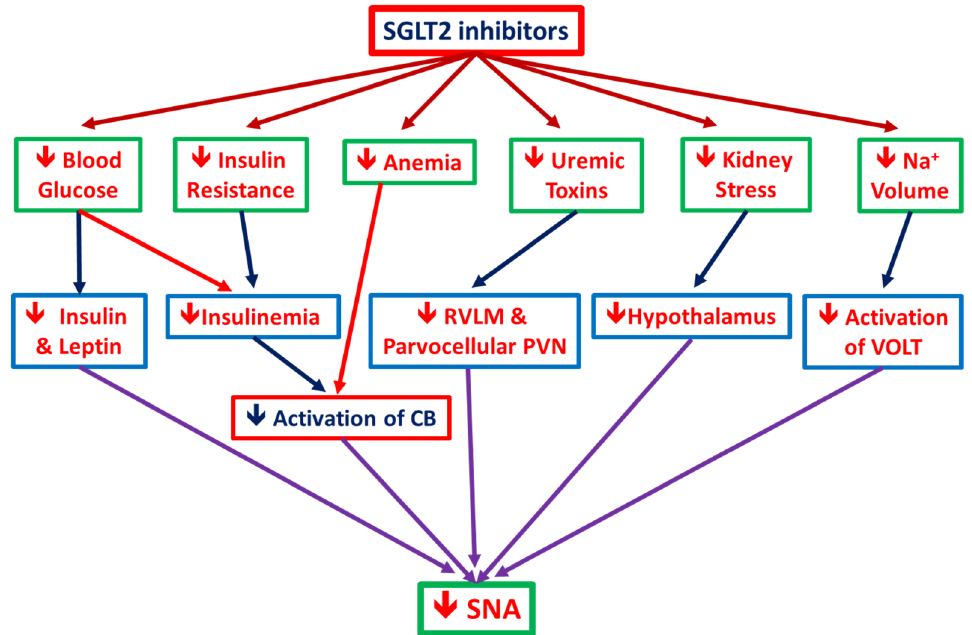
Figure 3. Possible mechanisms of SGLT2 inhibitors on reducing sympathetic nervous activity (SNA): since hypernatremia can activate organum vasculosum laminae terminalis (OVLT) neurons directly, it thus also augments muscle sympathetic nerve activity (SNA) and reduces renal SNA, thereby elevating blood pressure and probably increasing renal natriuresis. SGLT2 inhibitors elicit a reduction in SNA by decreasing insulin, leptin, and blood glucose levels; by improving insulin resistance and hyperinsulinemia; by improving anemia, which could reduce the activation of carotid body (CB); as well as by reducing sodium volume and protein bound uremic toxins level, which inhibits the activation of OVLT in the anteroventral third ventricle (AV3V) region of the hypothalamus.